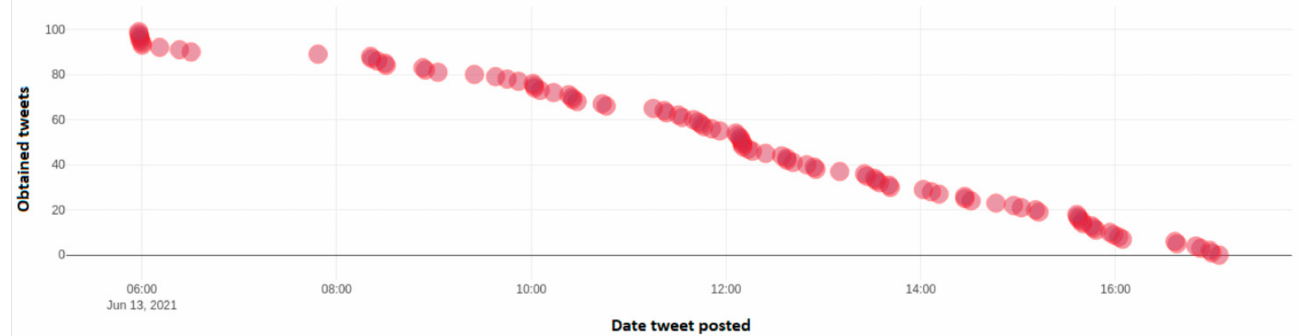
Figure 22. Mined tweets based on negative hashtag (# Σ υριζα _ απατε ´ ω νε ς ) (100 tweet sample) for SYRIZA